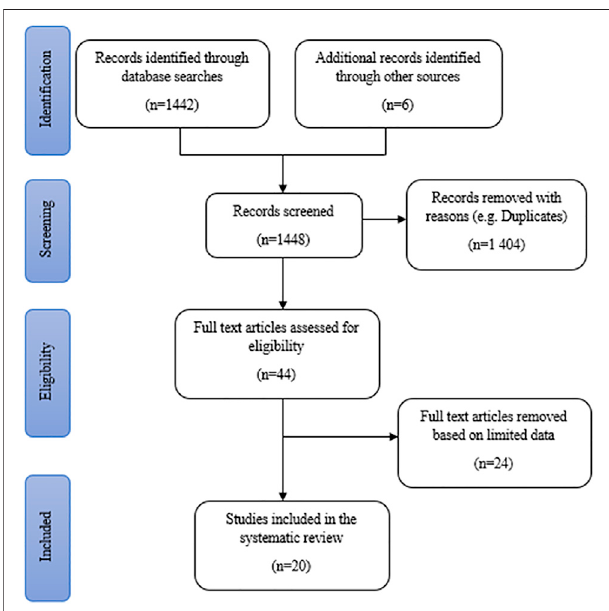
FIGURE 1 | Search strategy results for the identi fi cation of studies included in the systematic review.